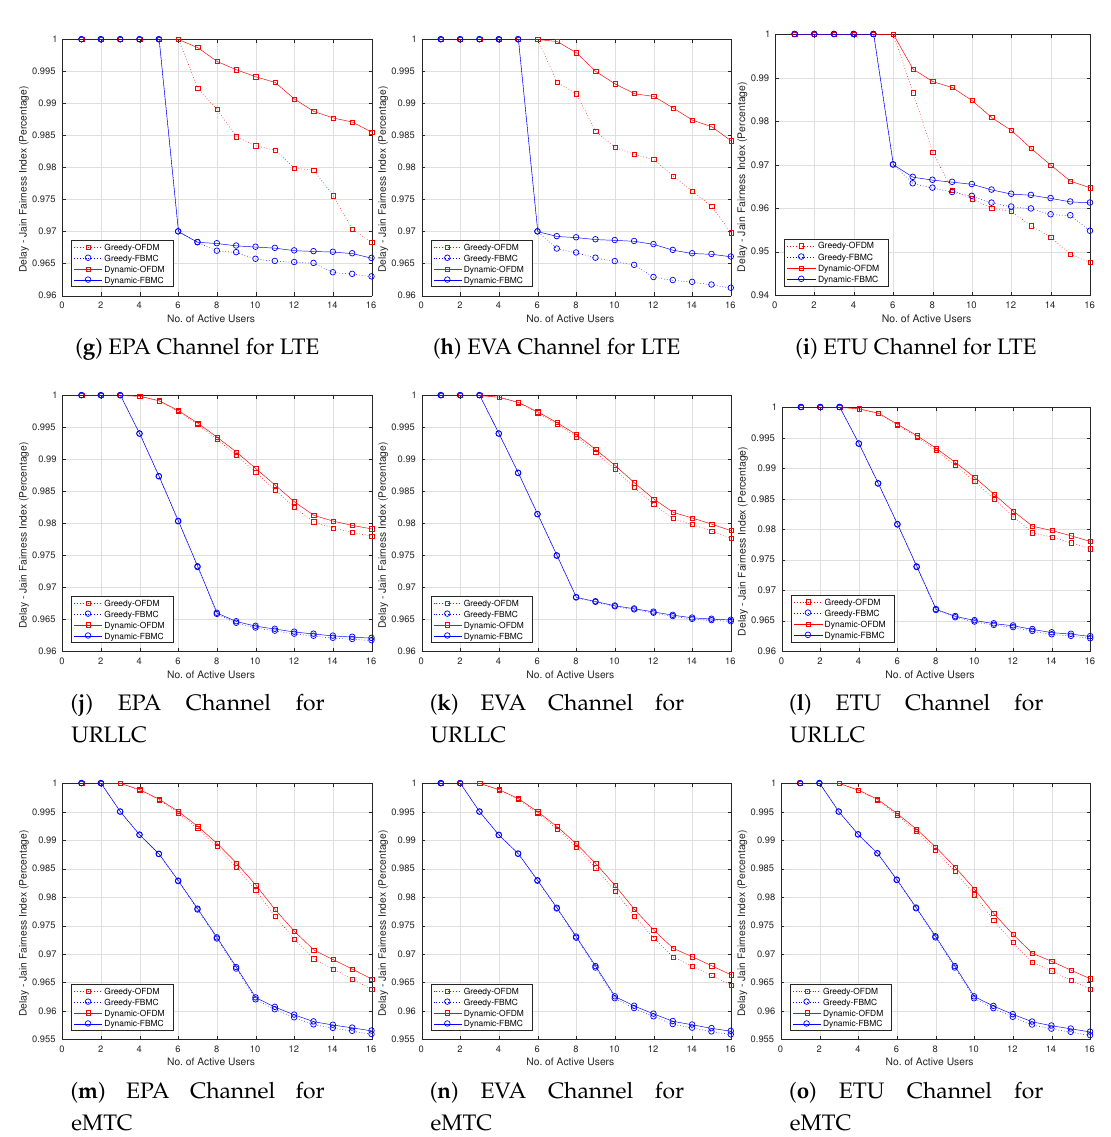
Figure 6. Delay Jain Fairness Index for the greedy and dynamic